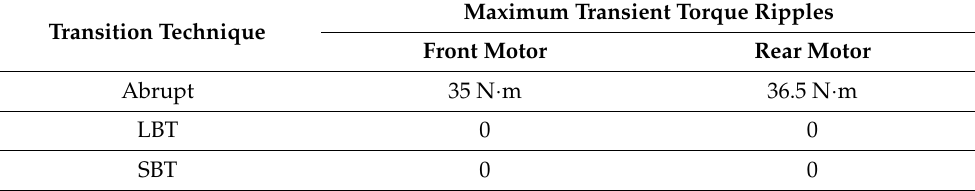
Table 5. Torque ripples using all transition